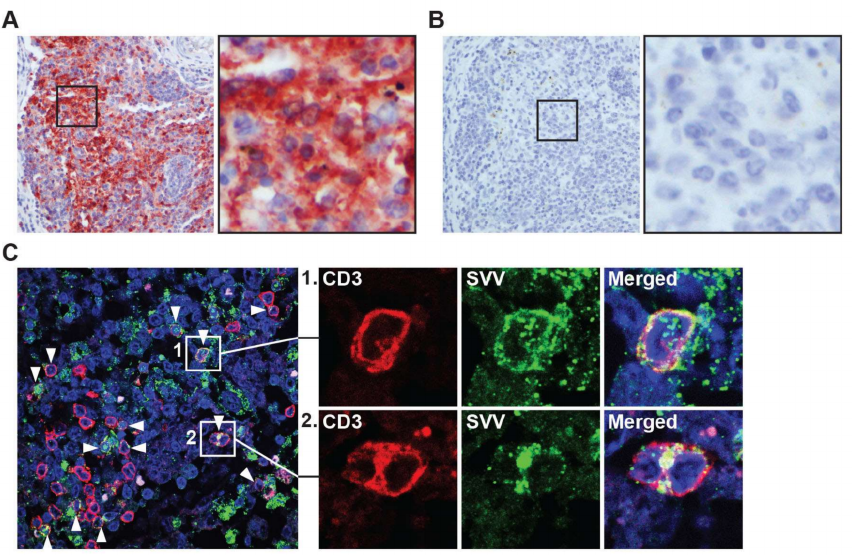
Figure 2. Detection of SVV in intestine-draining mesenteric lymph nodes during acute SVV infection of African green